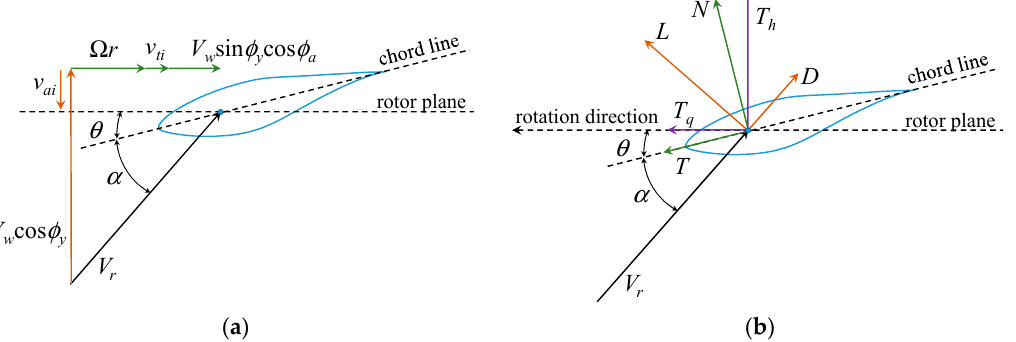
Figure 3. Schematic of the sectional velocity triangle and aerodynamic forces. ( a ) velocity triangle; ( b ) aerodynamic forces.